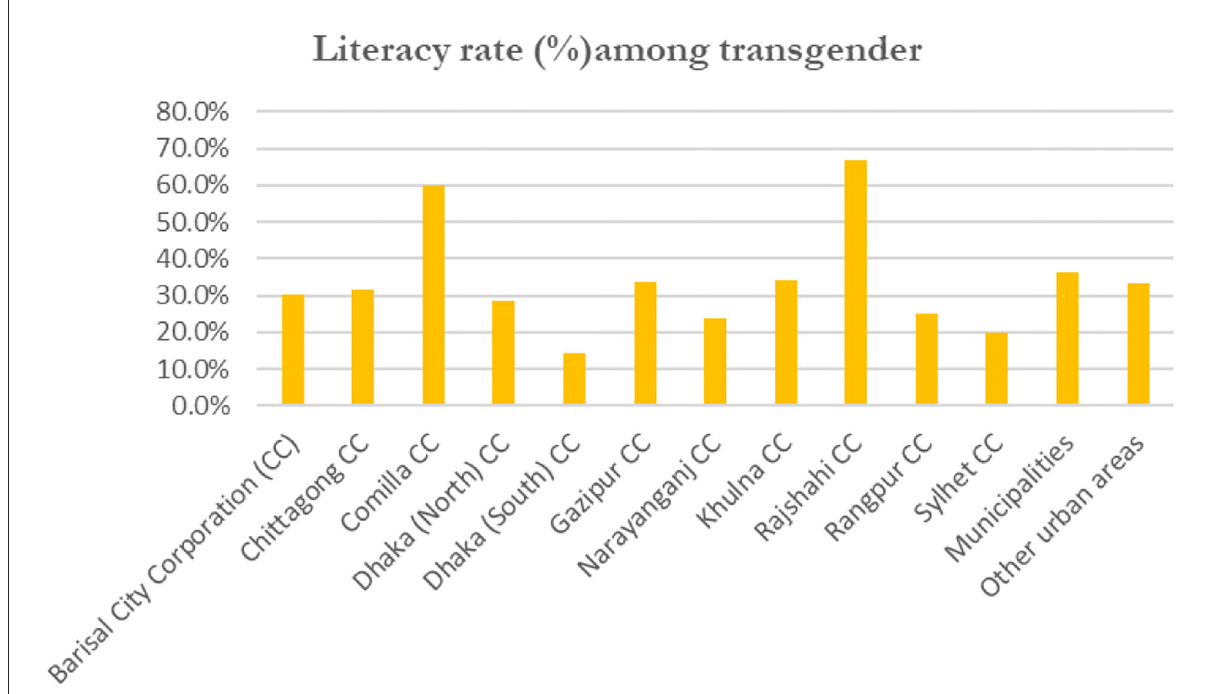
FIGURE1 Literacy rate (7 years and older) among transgender slum dwellers (data source Bangladesh Bureau of Statistics,